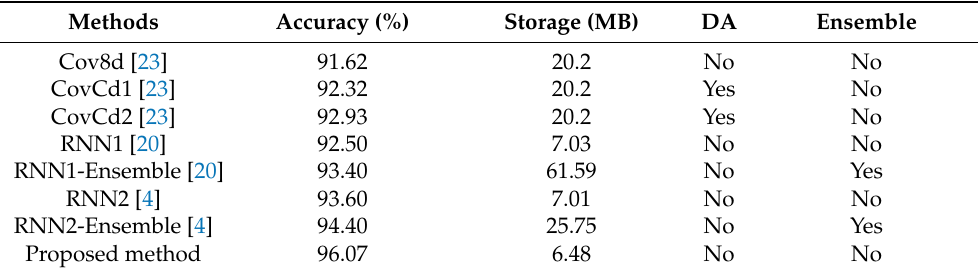
Table 3. Performance comparison of different deep-learning methods on the IAHCC-UCAS2016 dataset.